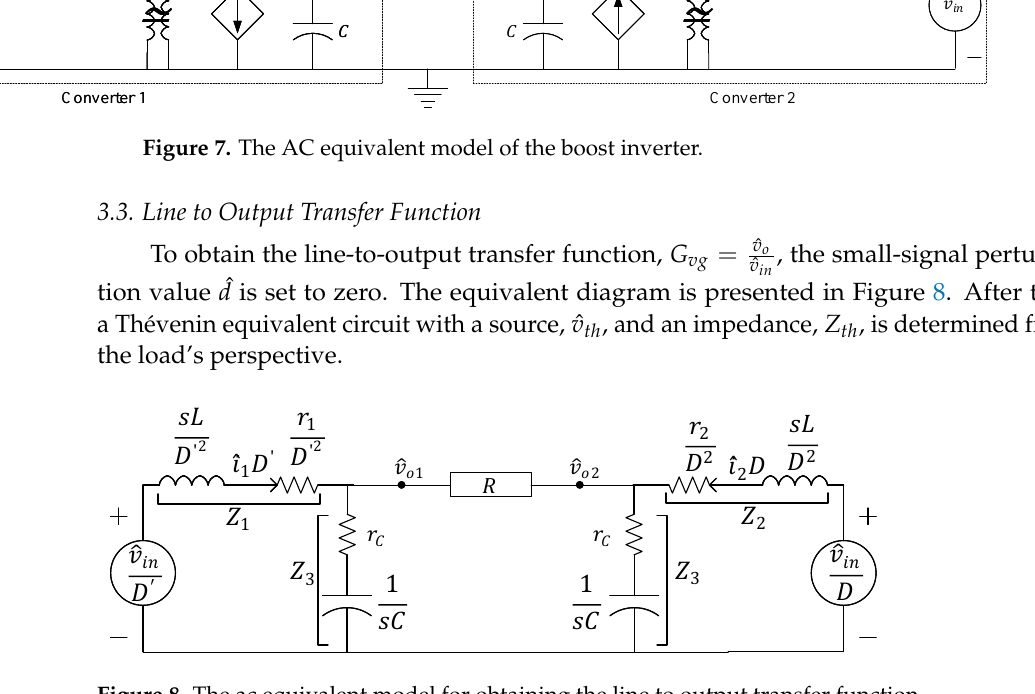
Figure 8. The ac equivalent model for obtaining the line to output transfer